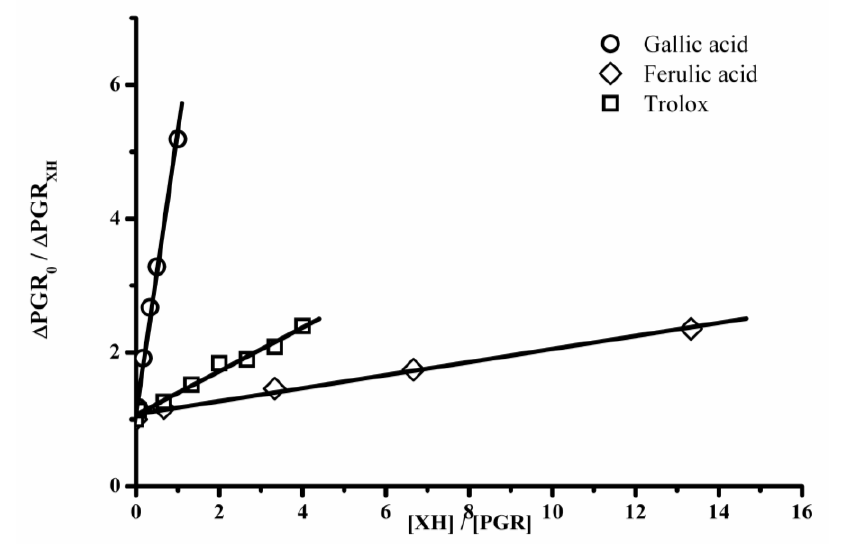
Figure 6. Dependence of  PGR gallic acid, and ferulic